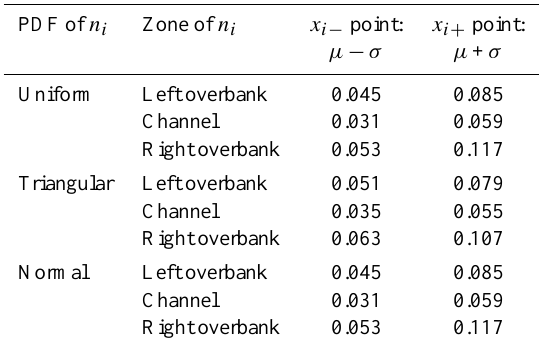
Table 9. Points estimate method. Values of bed friction used to eval- uate the performance